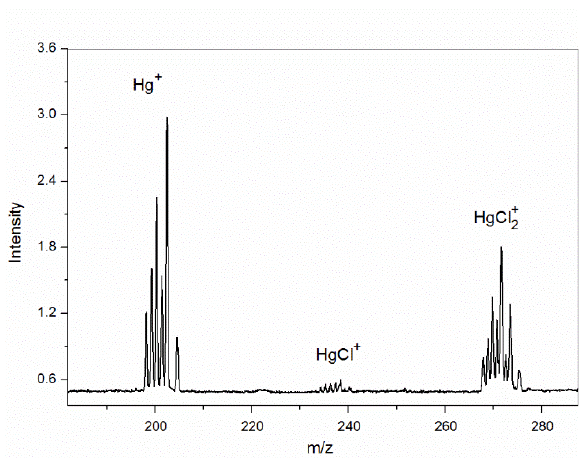
Figure 1: Mass spectra of HgCl condensed HgCl